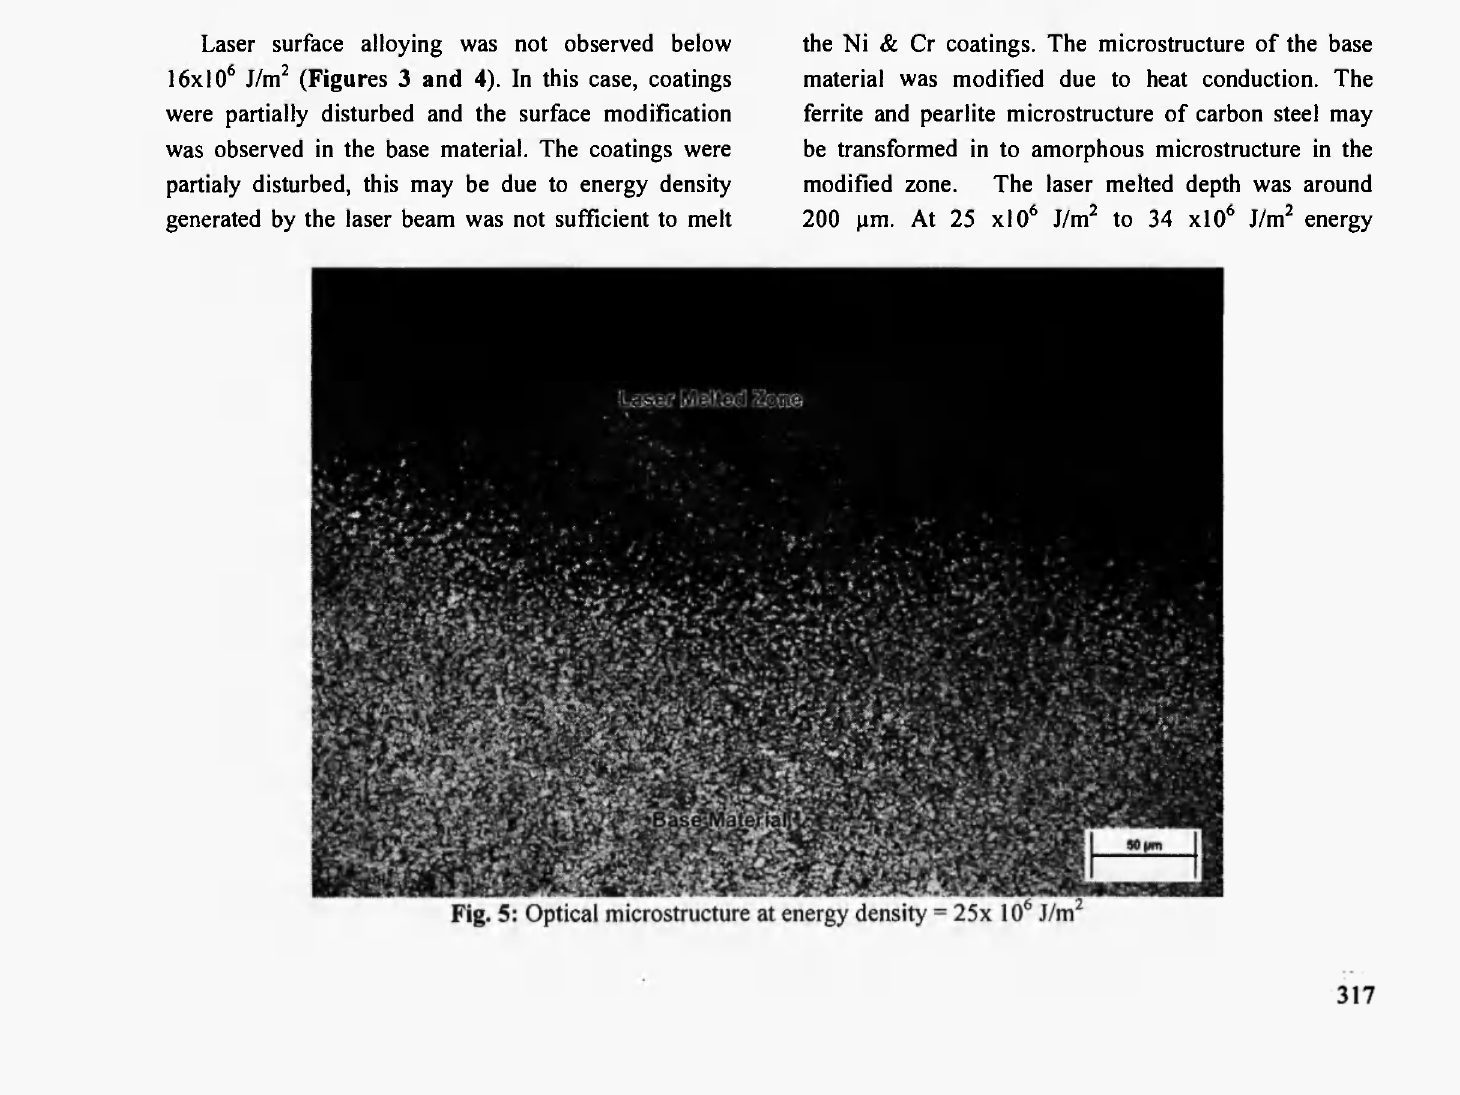
Fig. 4: Optical microstructure at energy density = 1 6 x 10 J/m Laser surface alloying was not observed below the Ni & Cr coatings. The microstructure of the base 16xl0 6 J/m 2 (Figures 3 and 4). In this case, coatings material was modified due to heat conduction. The were partially disturbed and the surface modification ferrite and pearlite microstructure of carbon steel may was observed in the base material. The coatings were be transformed in to amorphous microstructure in the partialy disturbed, this may be due to energy density modified generated by the laser beam was not sufficient to melt